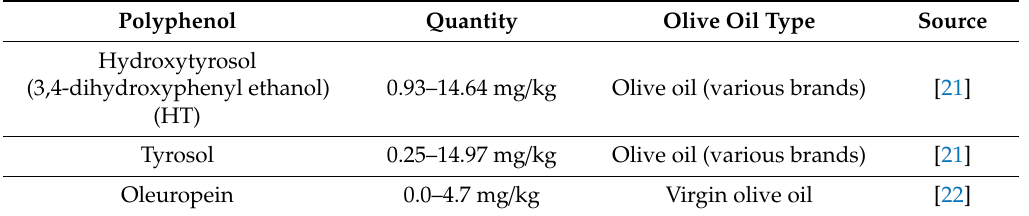
Table 1. Most abundant phenolic compounds found in olive oil.